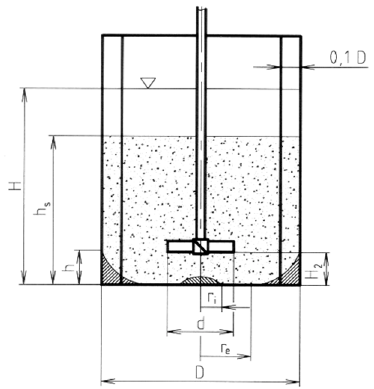
Figure 11. Arrangement of a layer of particles settled at the bottom of the mixing vessel and the interface between the formed suspension and the clear liquid in the agitated batch.